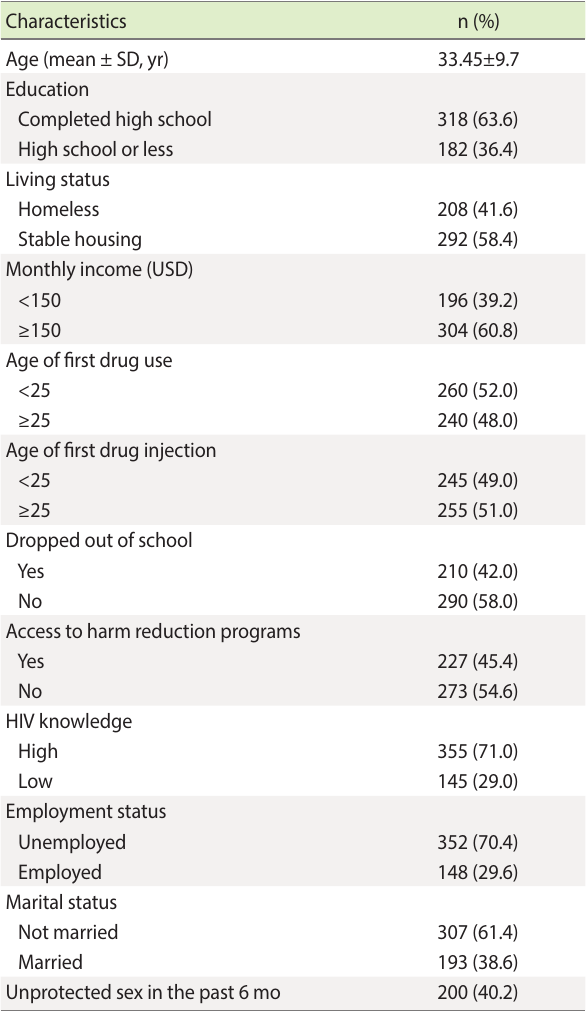
Table 1. Overall characteristics of the sample of PWID, Tehran, 2016 (n=500)